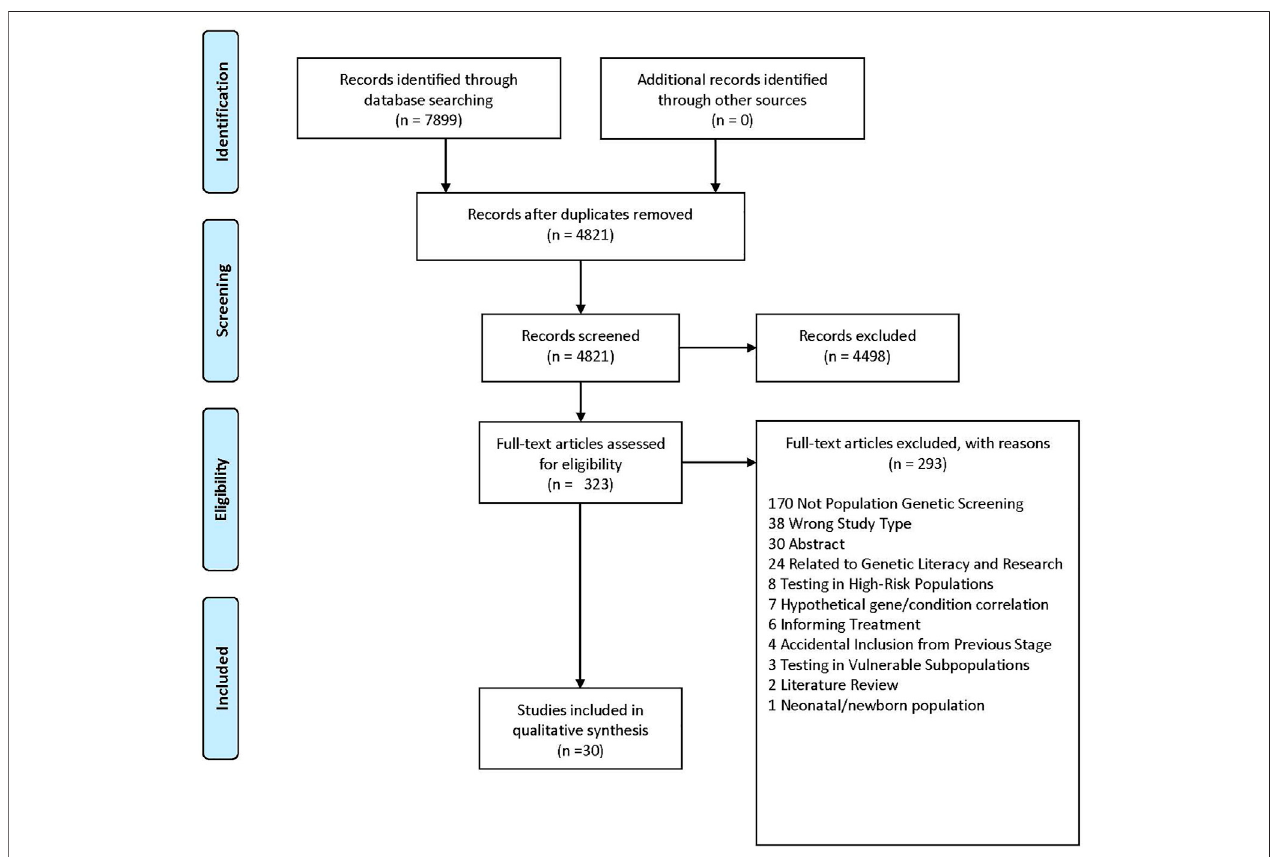
FIGURE 1 | PRISMA